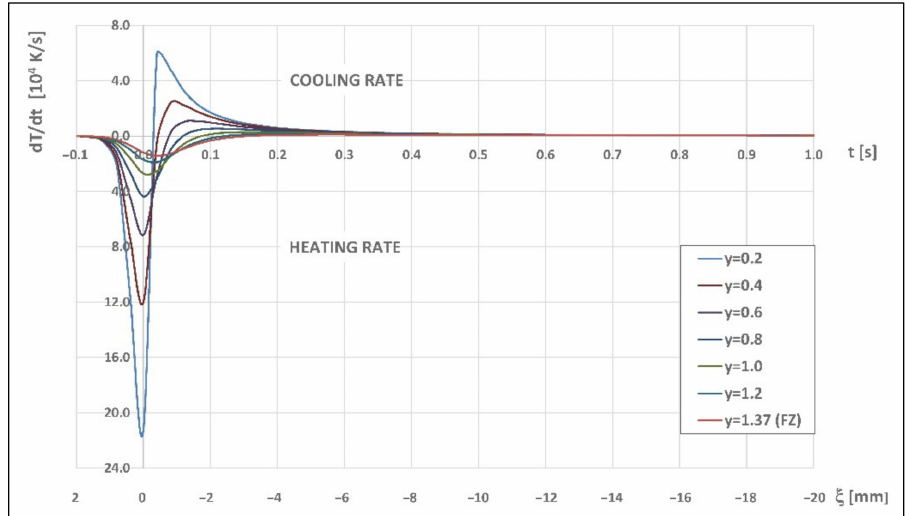
Figure 5. Heating and cooling rate curves for fixed points on the plane xy, at z = 5 mm, parameterized at different values of the y coordinate (distance of the point from the welding plane) within